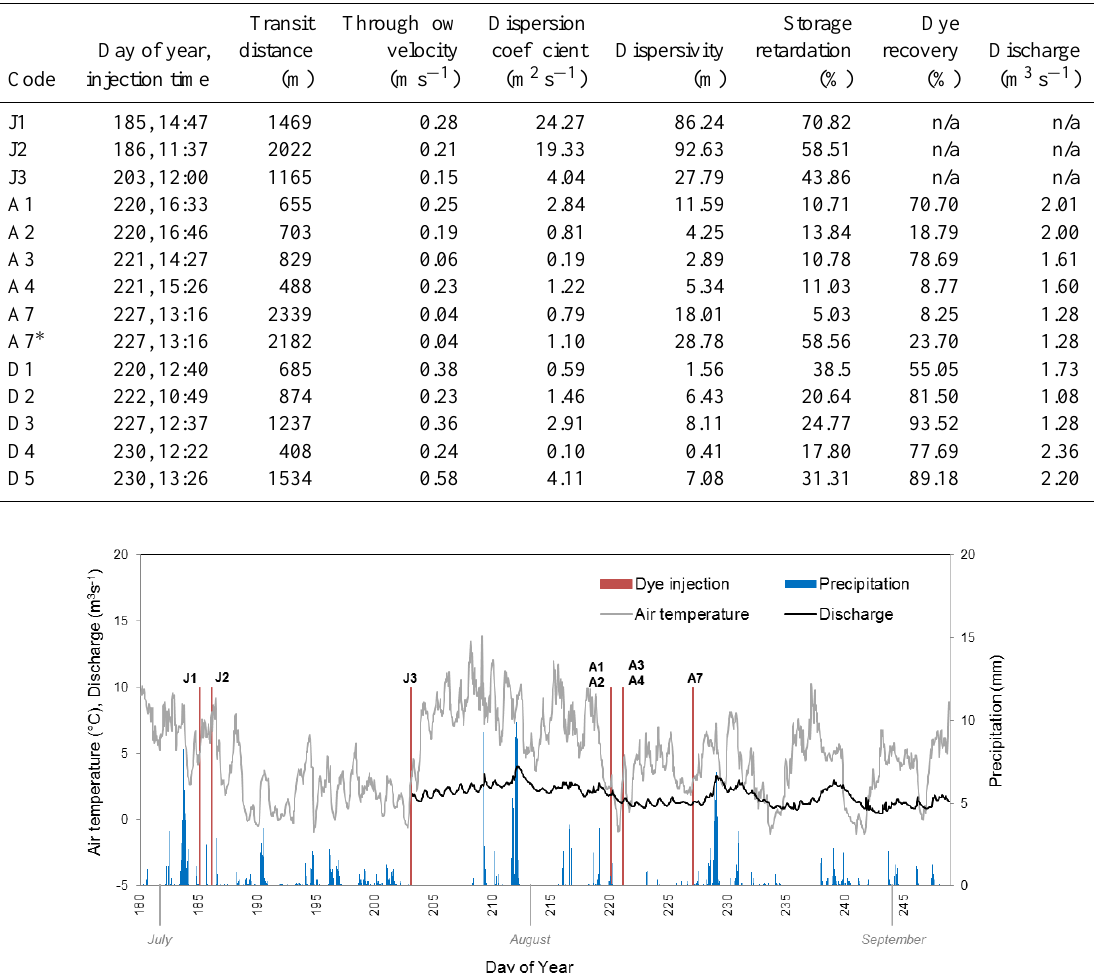
Table 2. Results of dye tracing analysis from automatic sampling of fluorescence (A7 ∗ is based on manual sampling in the southernmost proglacial outlet). Here, discharge for A and J experiments is that calculated from stage recorded at the river gauging station averaged over the duration of each experiment, and for D experiments is the computed discharge based on dye tracing for production of the rating curve.